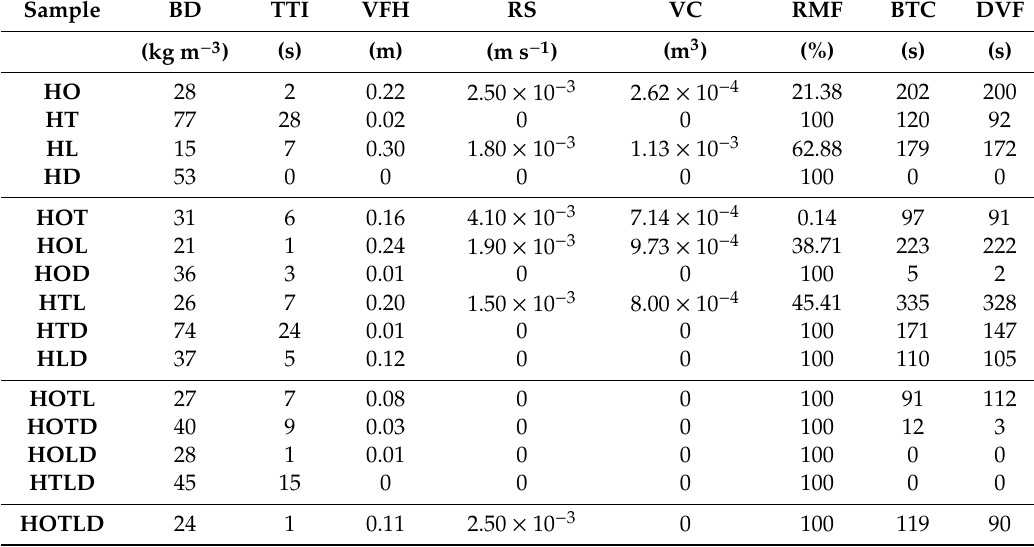
Table 4. Flammability metrics for mixtures of litter collected from Halls Creek (H) as specified by a simplex centroid design. The materials include: other (bark, hard woody fruits) (O), twigs (T), leaves (L), and decomposed material (D). Flammability metrics are: bulk density (BD), time-to-ignition (TTI), vertical flame height (VFH), rate of spread (RS), volume consumed (VC), residual mass fraction (RMF), burn to completion (BTC), and duration of visual flaming